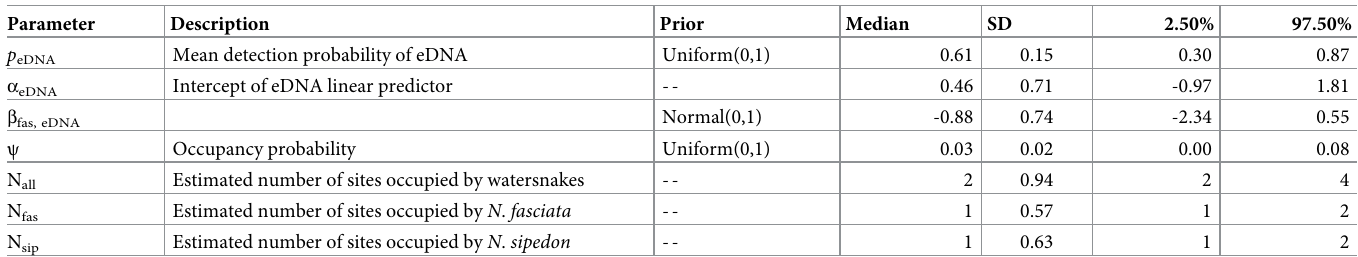
Table 5. Parameters, prior distributions, and posterior summaries for detection and occupancy parameters from an occupancy model based on eDNA surveys only. Parameter